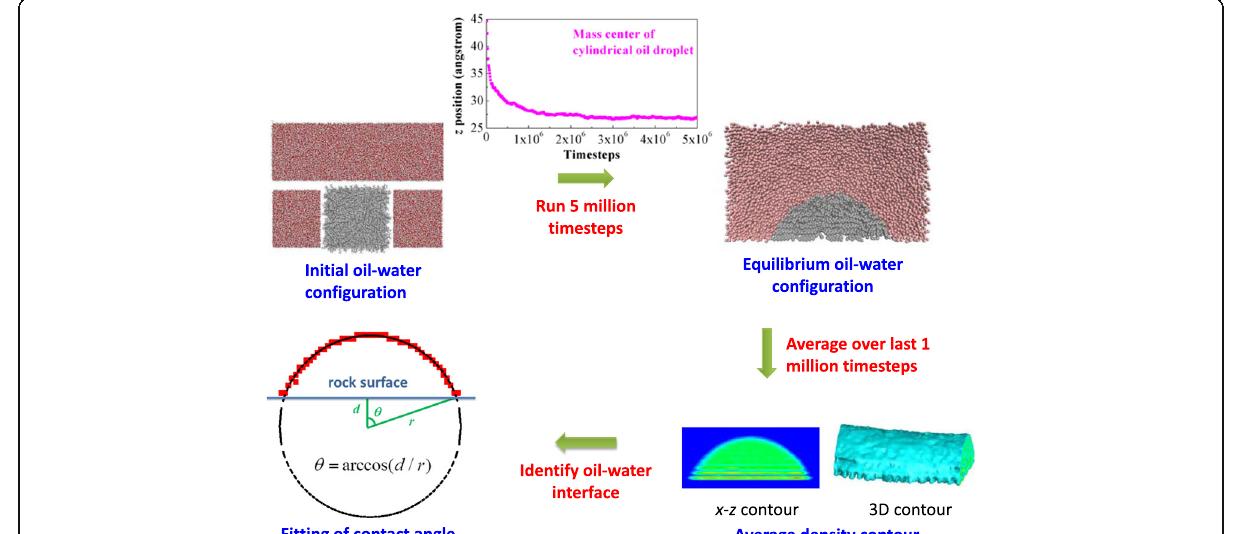
Fig. 2 Calculation procedures for the contact angles of cylindrical oil